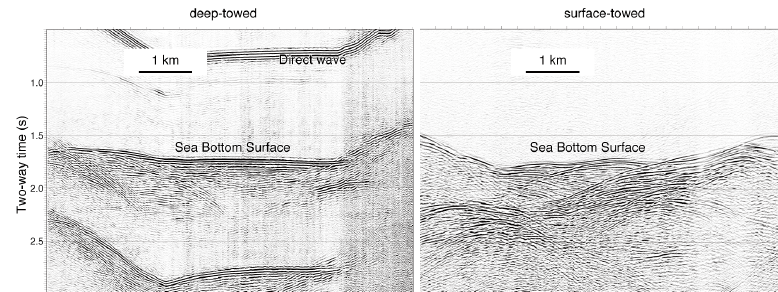
Figure 10. Comparison of the reflection images obtained by new system with surface-towed cable, which is same scaled profiles.